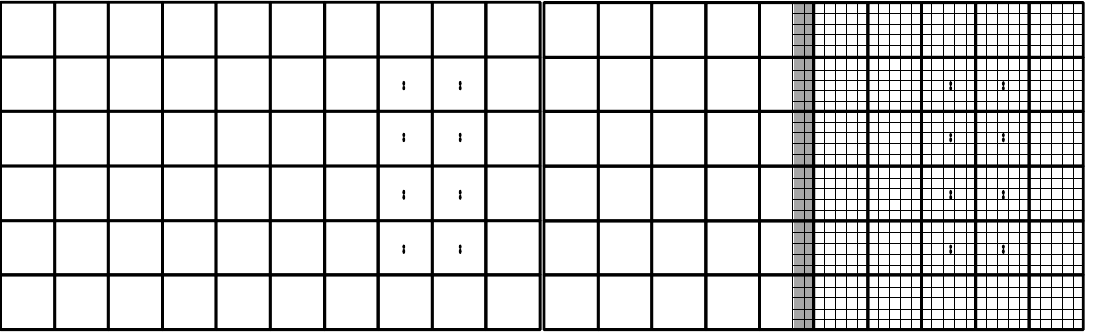
Figure 4. Example of positioning of 10 m rotor diameter turbines on a 50 m coarse resolution grid (left) and a 10 m nested high resolution grid (right) using 5 rotor diameters (RD) spacings in both the lateral and longitudinal directions. Shaded cells are the boundary interface of the nested domain.